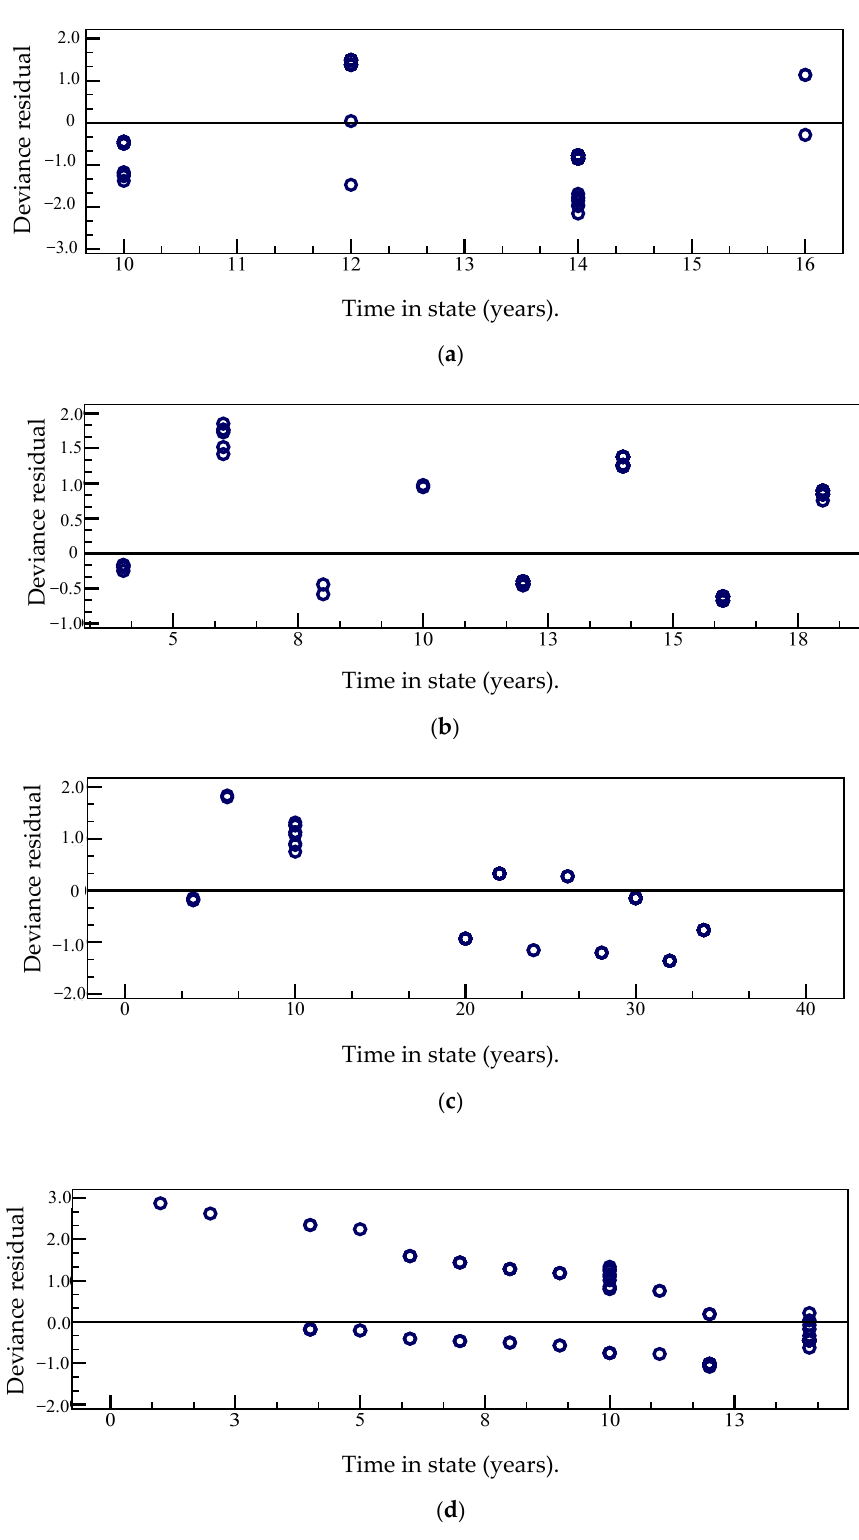
Figure 4. Deviation of the fit model for the sojourn time of four states. ( a ) State 1; ( b ) State 2; ( c ) State 3; ( d ) State